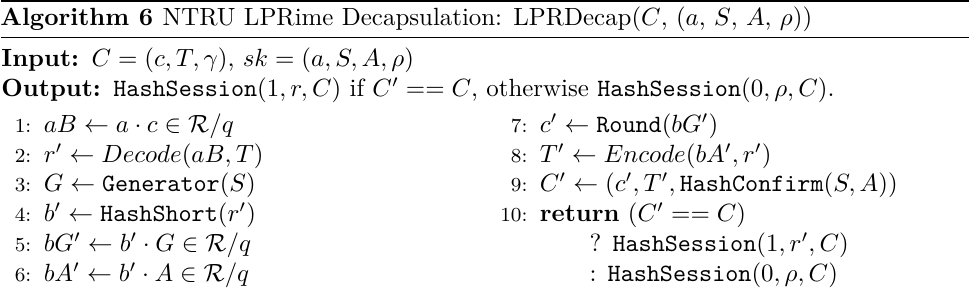
Algorithm 6 NTRU LPRime Decapsulation: LPRDecap( C , ( a , S , A , ρ